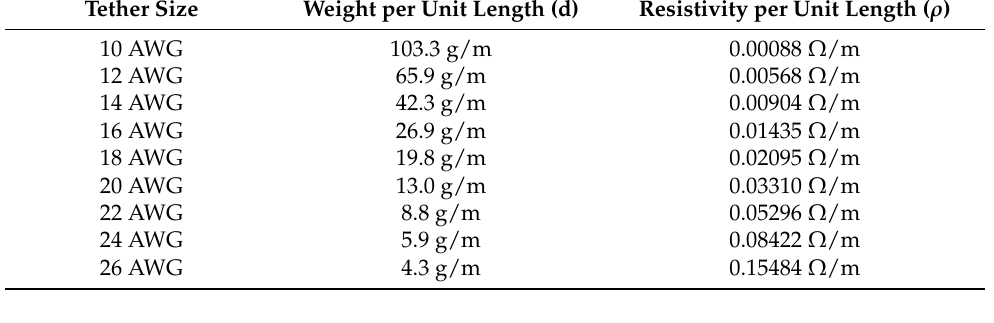
Table 3. Parameters of the 44A012X series power tether.